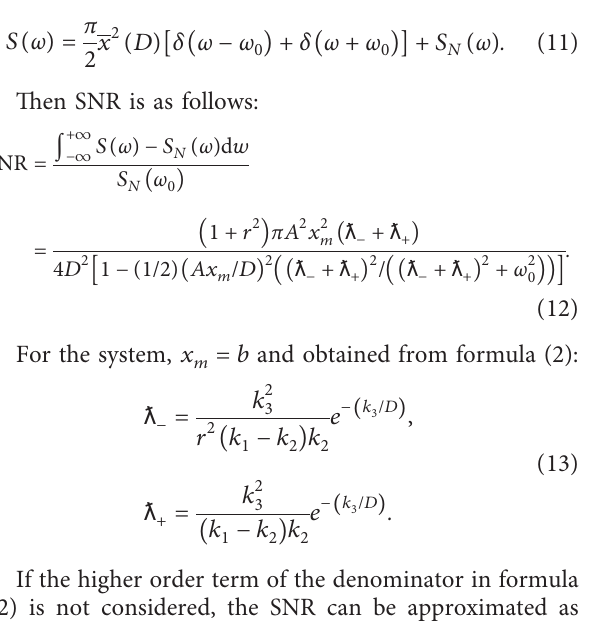
Figure 1: Potential function U ( x )